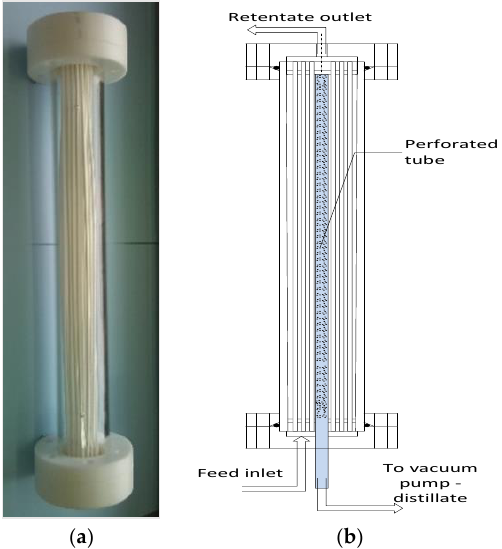
Figure 2. ( a ) A view of M1 custom-made vacuum membrane distillation (VMD) module; ( b ) a cross-sectional view of M2 VMD module.